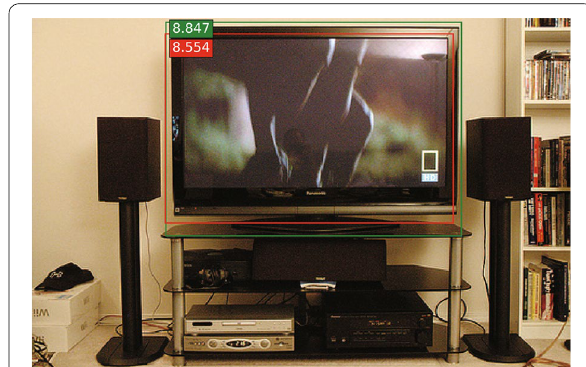
Fig. 12 Examples of results in Pascal3D TV monitor. The ground truth distance and estimated distance are written in green and red boxes respectively. The unit of distance is based on CAD models